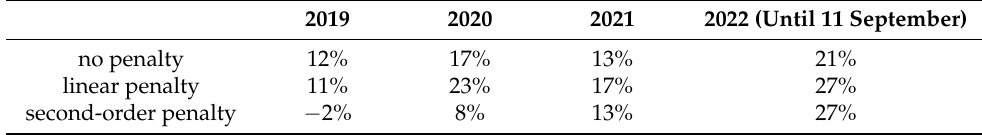
Table 2. Cost savings of building constructed between 2001 and 2010 for different reward functions.